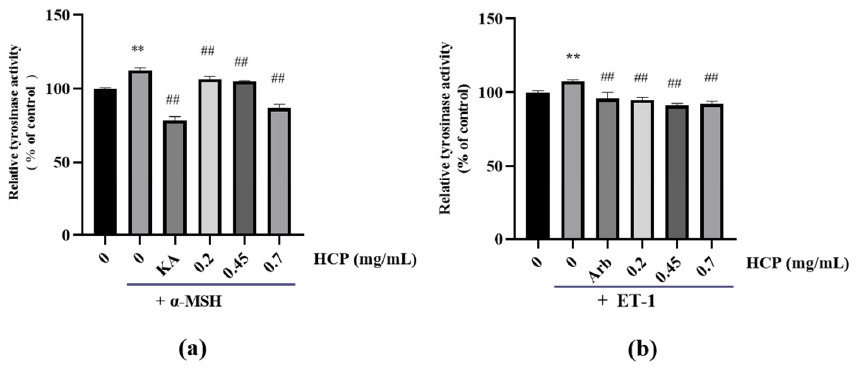
Figure 4. ( a ) HCP inhibits the intracellular tyrosinase of α‐ MSH ‐ treated MNT ‐ 1 melanoma cells. ( b ) HCP inhibits the intracellular tyrosinase of ET ‐ 1 ‐ treated MNT ‐ 1 melanoma cells. All data are expressed as mean ± SD ( n ≥ 3) (** p < 0.01 vs. the untreated control group; ## p < 0.01 vs. α‐ MSH ‐ treated group or ET ‐ 1 ‐ treated group)